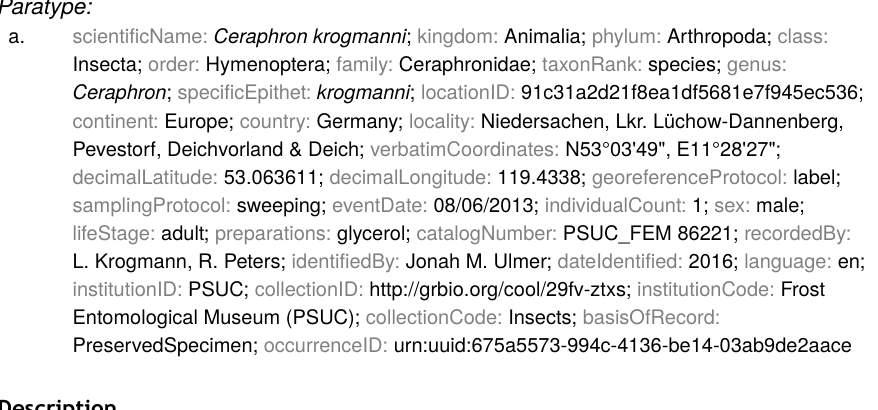
Coloration: Colour hue pattern female: NOT CODED. Colour intensity pattern female: NOT CODED. Colour hue pattern male: brownish, legs yellowish, fore wing brown, with a transverse discoloured band at level of stigmal vein. Colour intensity pattern male: fl agellum, tibiae and tarsi lighter than scape, pedicel, mandible, tegula, coxae and femora. Head: Foveolate sculpture on body count: present on mesosoma and frons. Head width vs. head height: HW:HH=0.9—1.0. Head width vs. interorbital space (HW/IOS) Female: NOT CODED. Head width vs. interorbital space (HW/IOS) Male: 1.4—1.5. Head width vs. head length lateral view (HW / HL): 1.6. Maximum eye diameter vs. minimum eye diameter: 1.1—1.2. Dorsal carina of occipital depression presence: absent. Dorsal carina of occipital depression medial continuity: NOT CODED. Occipital carina sculpture: smooth (Fig. 3a). Median fl ange of occipital carina count: present. Submedial fl ange of occipital carina count: present. Dorsal margin of occipital carina vs. dorsal margin of lateral ocellus in lateral view: occipital carina is ventral to lateral ocellus in lateral view. Preoccipital lunula count: present. Preoccipital ridge presence: present. Preoccipital furrow count: present. Preoccipital furrow anterior extension: adjacent anteriorly to the posterior margin of the median ocellus. Preoccipital furrow anterior region vs. posterior region sculpture: crenulate in its entire length. Preoccipital furrow anterior region width vs. posterior region width: as wide anteriorly as posteriorly. Preoccipital carina count: present. Preoccipital carina shape: complete. Preoccipital carina and occipital carina structure: occipital carina complete, preoccipital carina fused laterally with preorbital carina. Setal pit on vertex size: smaller than diameter of scutes. Female ocular ocellar line (OOL): posterior ocellar line (POL): lateral ocellar line (LOL): NOT CODED. Male ocular ocellar line (OOL): posterior ocellar line (POL): lateral ocellar line (LOL): 2:1—1.2:1—1.2 (Fig. 1a). postocellar carina count: absent. Preocellar pit count: present. Randomly sized areolae around setal pits on upper face count: absent. Antennal scrobe count: present. Carina delimiting antennal scrobe count: present. Transverse striation on upper face: present. Transverse scutes on